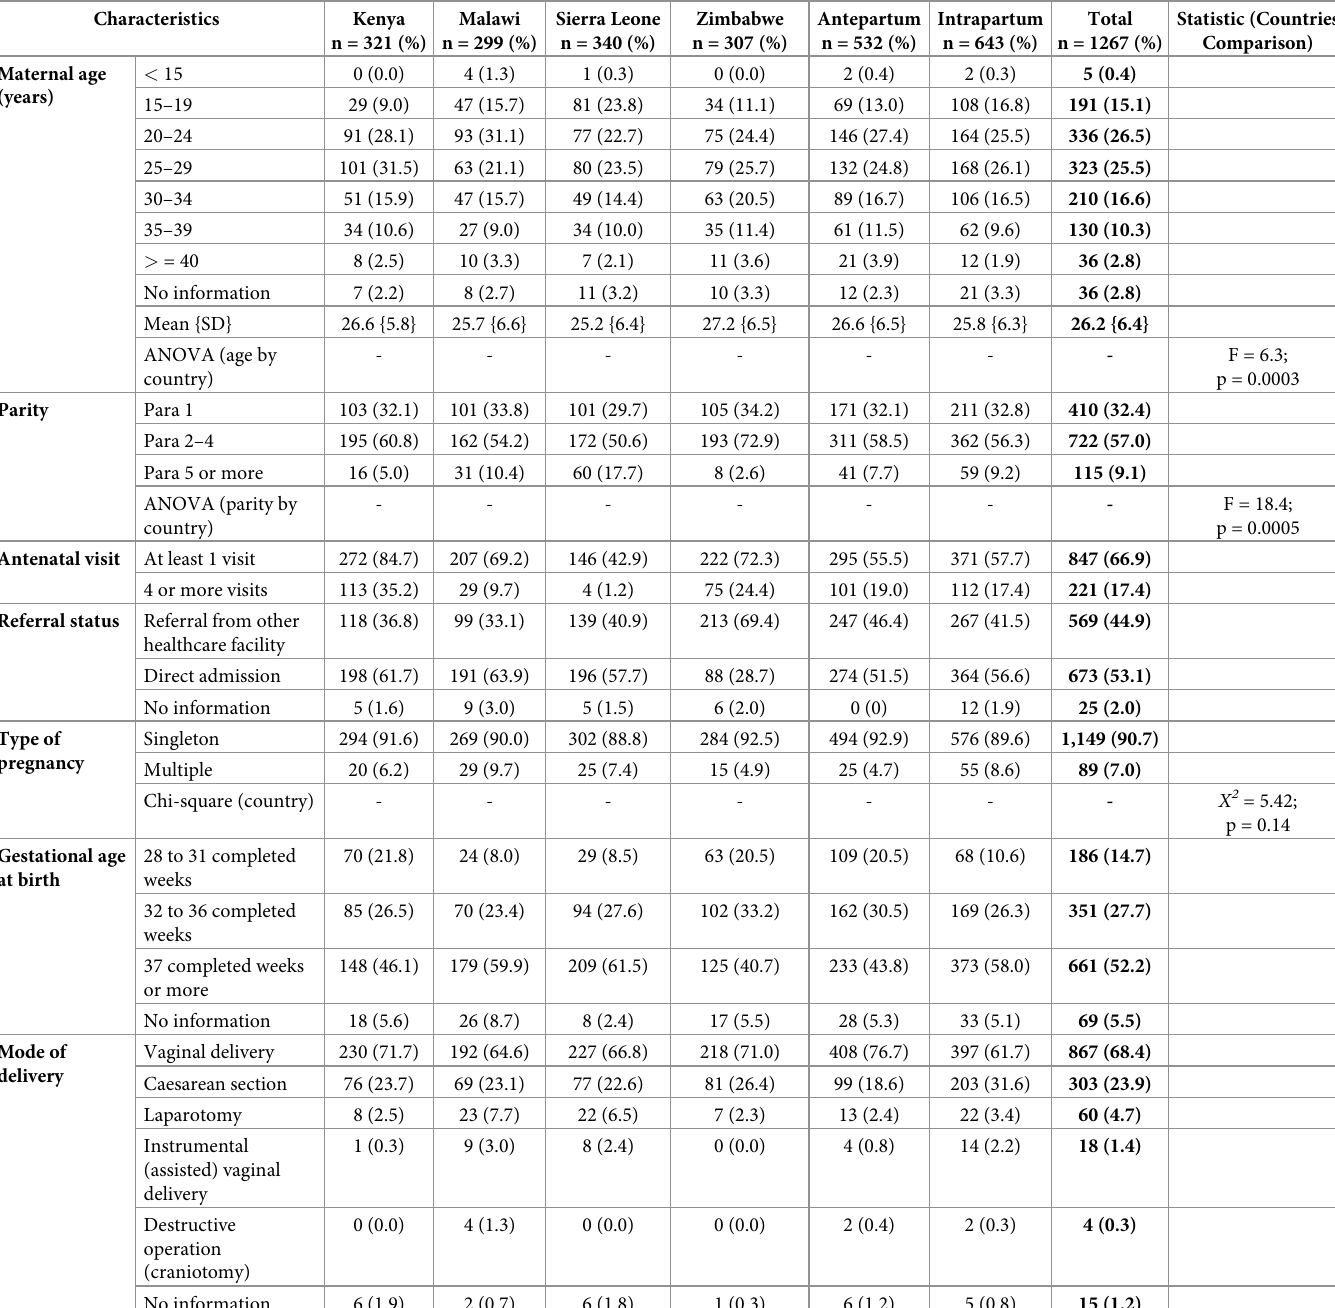
Table 2. Demographic and clinical characteristics of the study population.